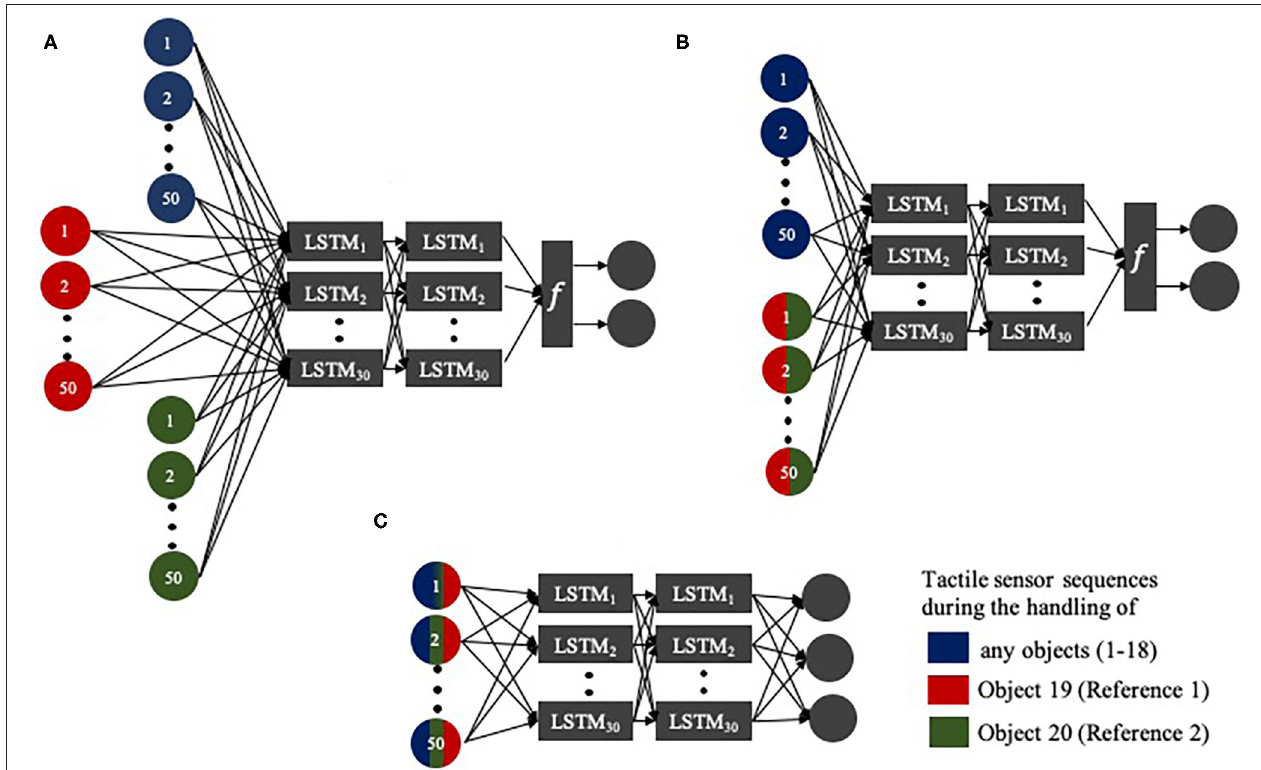
FIGURE 6 | (A) Triplet LSTM network, (B) Siamese LSTM network, (C) LSTM network. Network receives inputs from different objects as indicated by the colors. Multi-colored input bubbles indicate that the network receives sensor readings from either one of the indicated